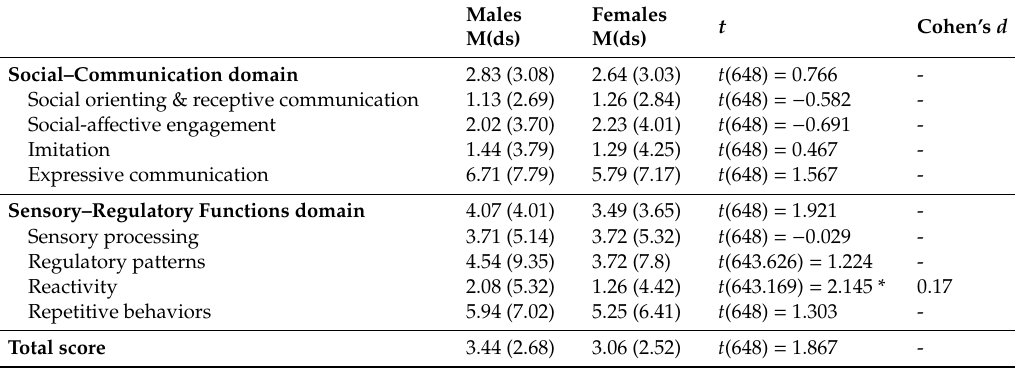
Table 1. Independent-sample t-test by gender on the FYI domains, total score, and constructs.